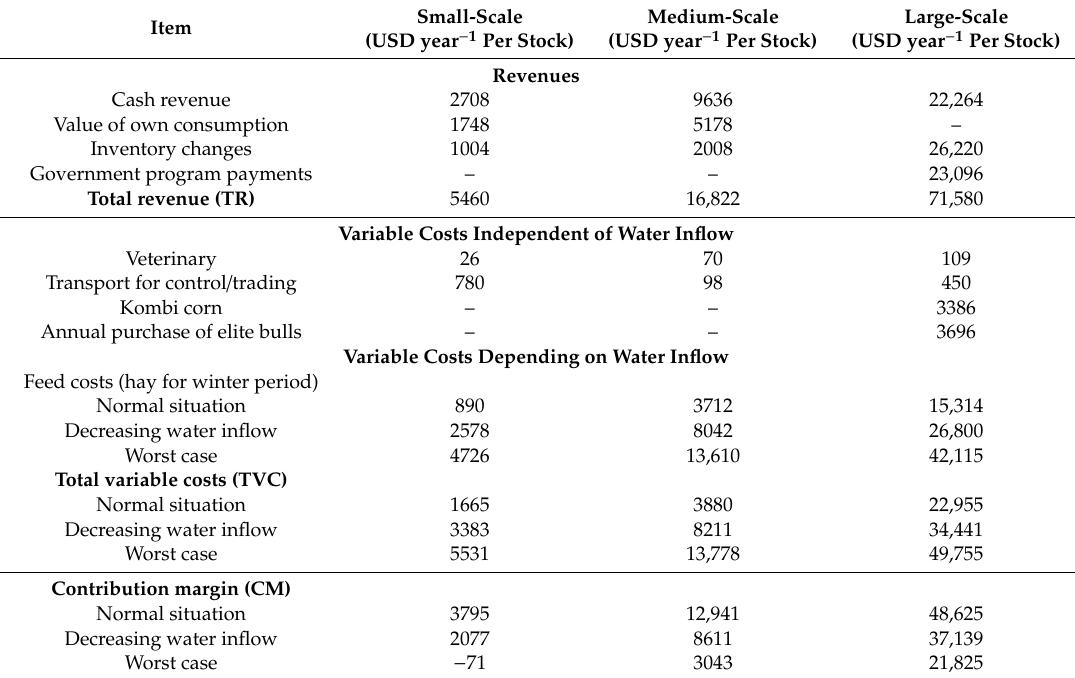
Table 8. Contribution margins of three types of individual farms in the Ili Delta for the three calculation scenarios (base year